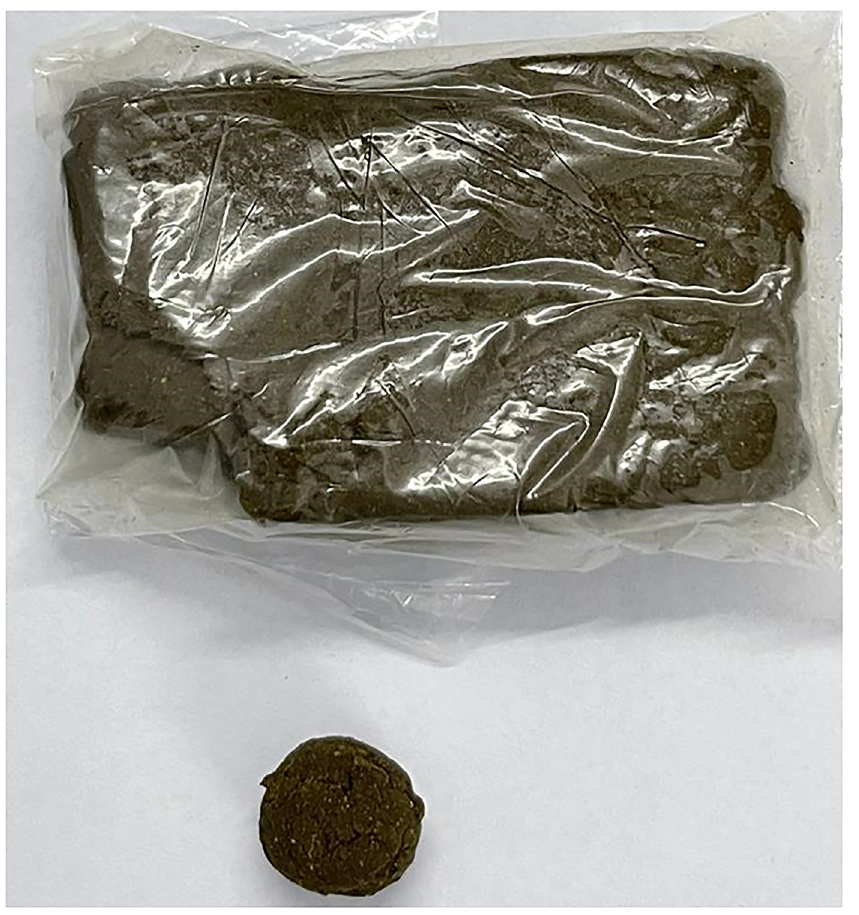
Fig 1. A packet of naswar with a